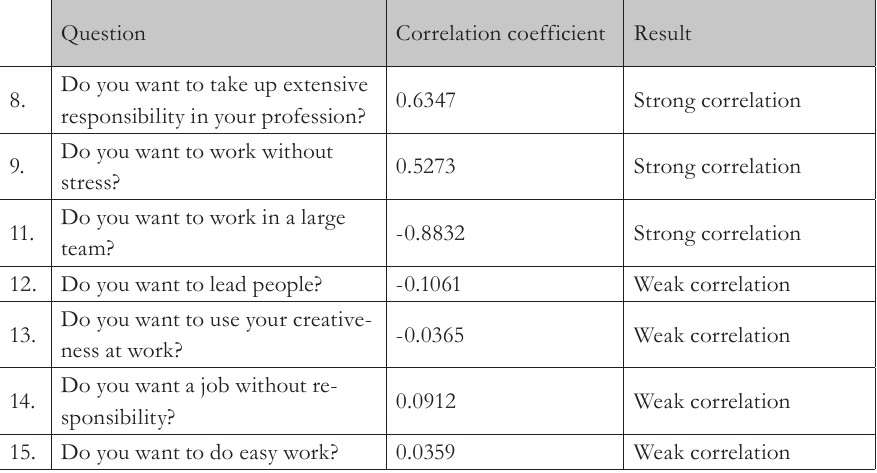
Tab. 3 – Correlation between intention to work as self-employed and attendance of the